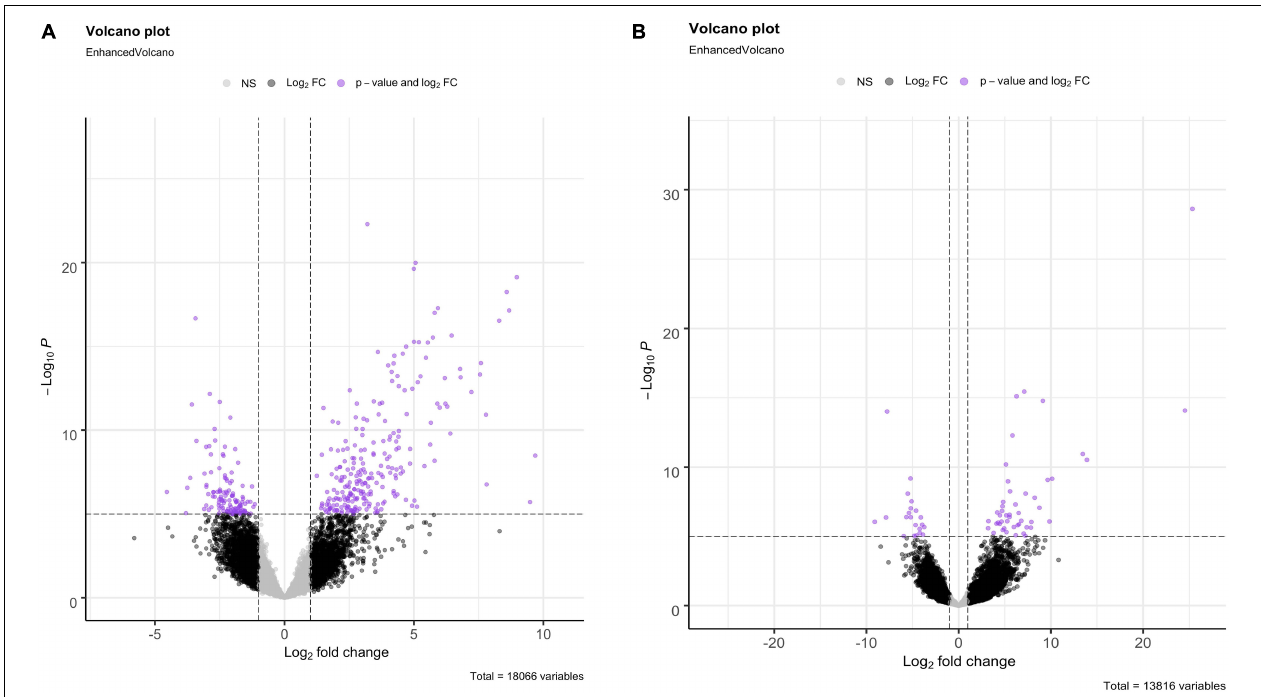
FIGURE 3 | Differential gene expression analysis of O. faveolata and M. cavernosa revealed unique gene expression patterns. (A,B) Log2 fold change in expression between control and disease-exposed fragments is shown on the x -axis, − log10 ( p -value) is shown on the y -axis. Gray points are non-significant genes, black have